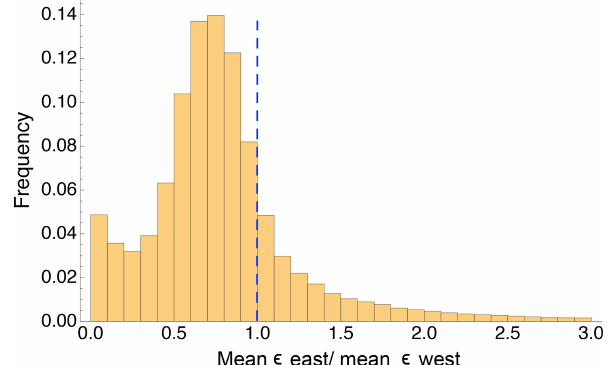
Figure 5. Histogram of the ratio of the average (cid:15) retrieved from the three 10m sonic anemometers on the eastern side of the Physics Site (towers P04, P05, and P10) to the average of (cid:15) retrieved from the two sonic anemometers on the western side of the Physics Site (tow- ers P03, P09). The vertical dashed line shows the 1.0 ratio, which would indicate no difference, on average, in (cid:15) between the two sides of the site.